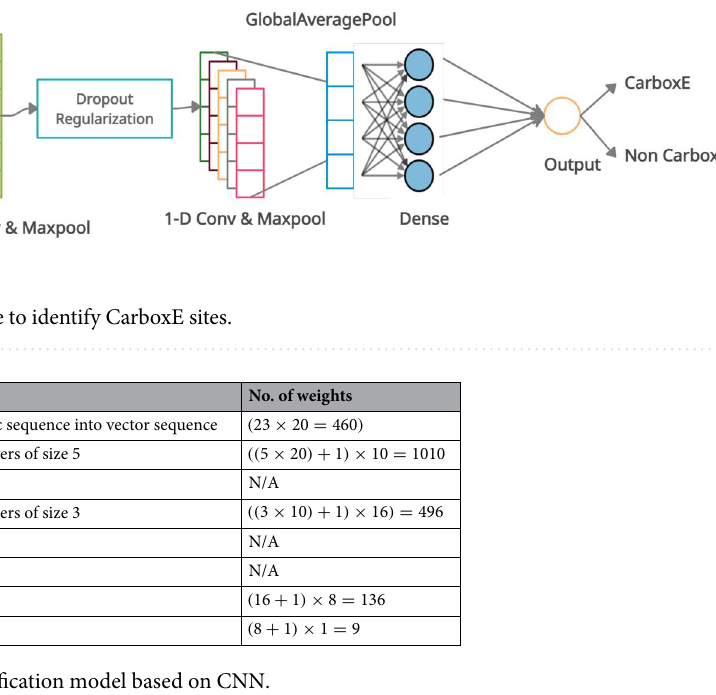
Table 7. CarboxE site identification model based on